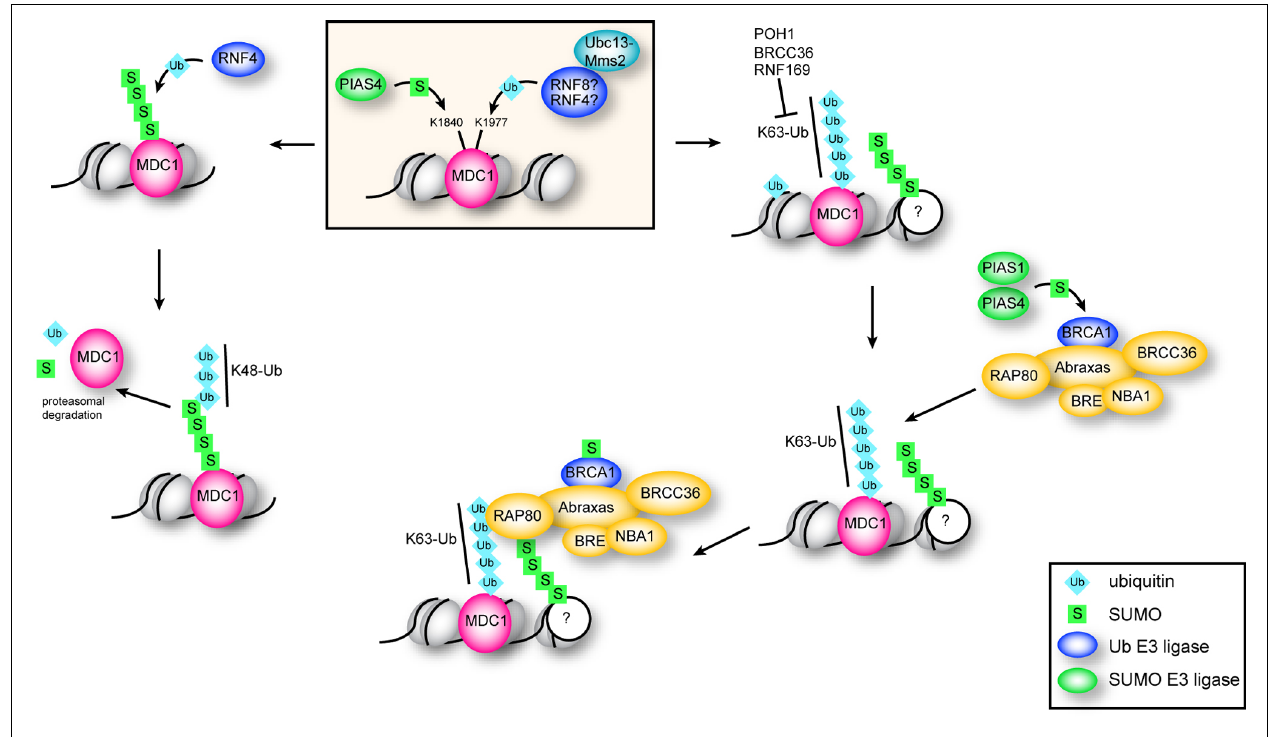
to recruit RAP80. RAP80 accumulates at DSBs through interaction with K63 chains and with sumoylated proteins via its two UIMs and SIM, and is required for efficient recruitment of BRCA1. Sumoylation of BRCA1 by PIAS1 and PIAS4 stimulates its ubiquitin ligase